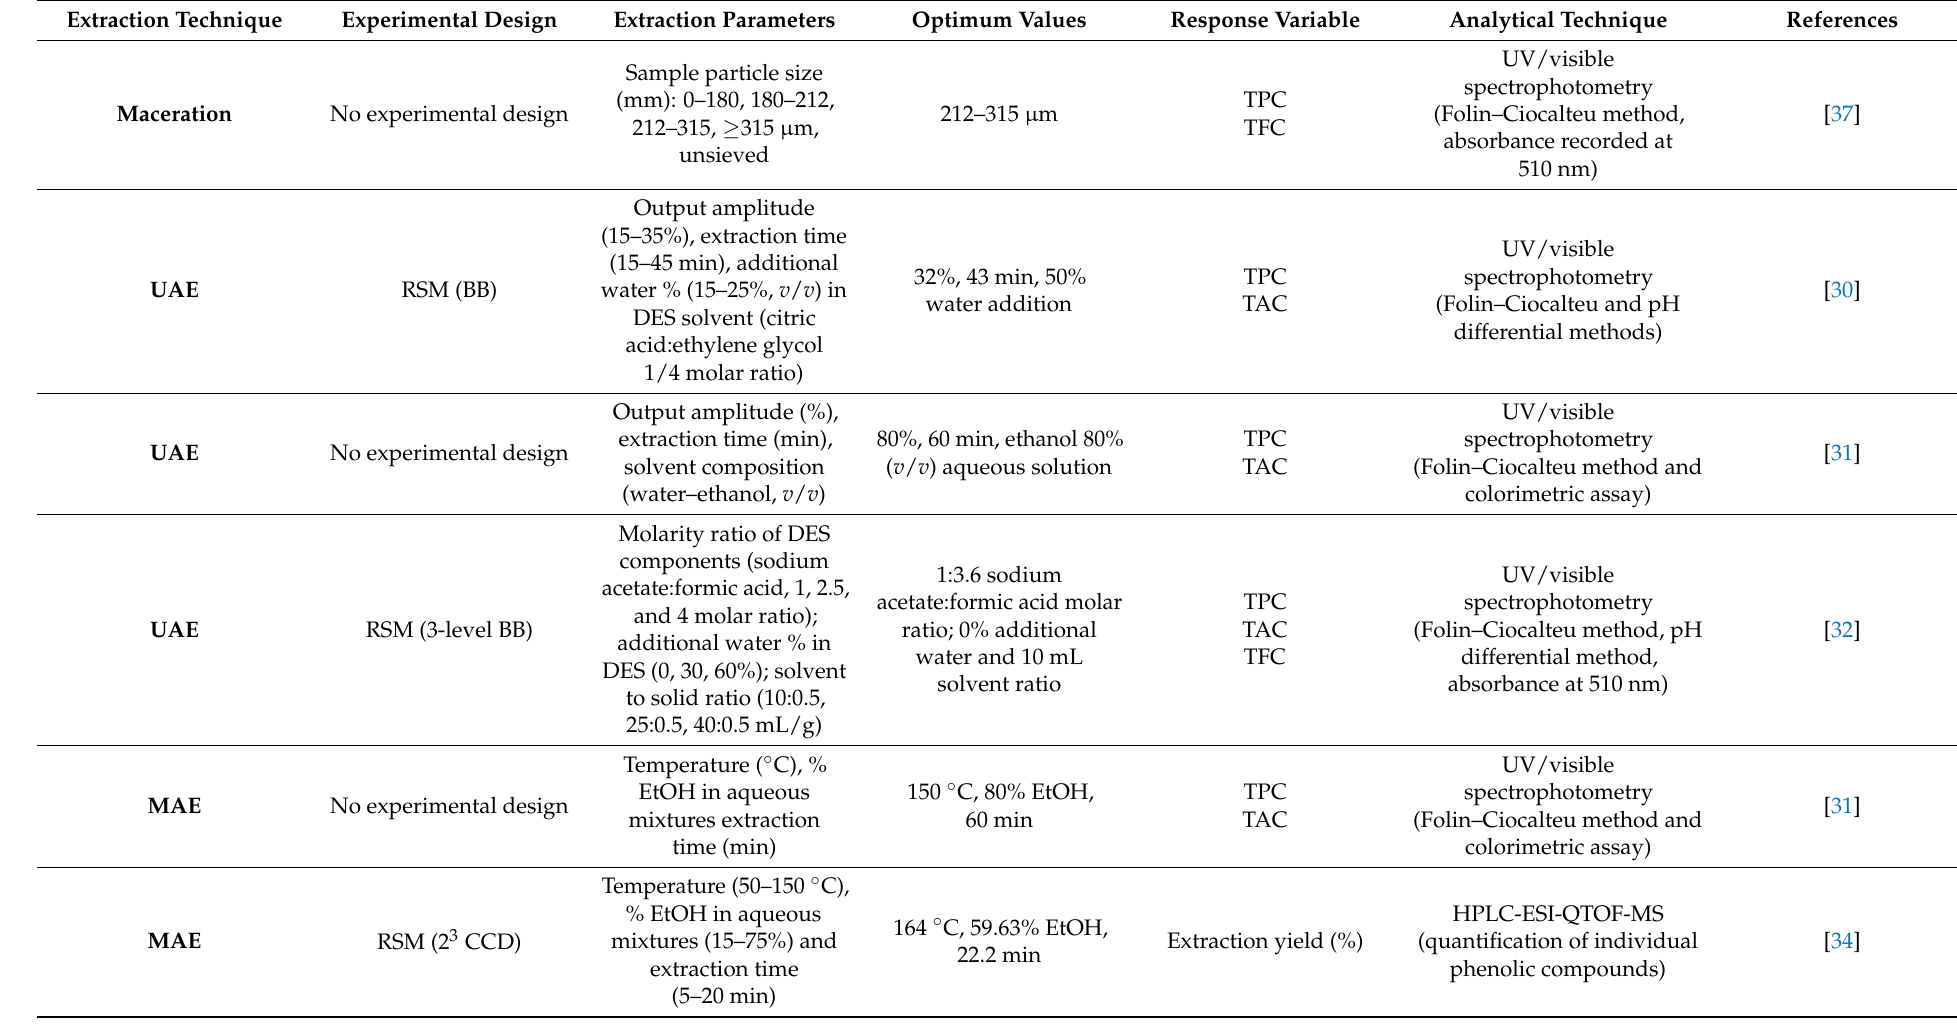
Table 1. Extraction methods, optimal conditions, and analysis of bioactive compounds for the obtention of Hibiscus sabdariffa